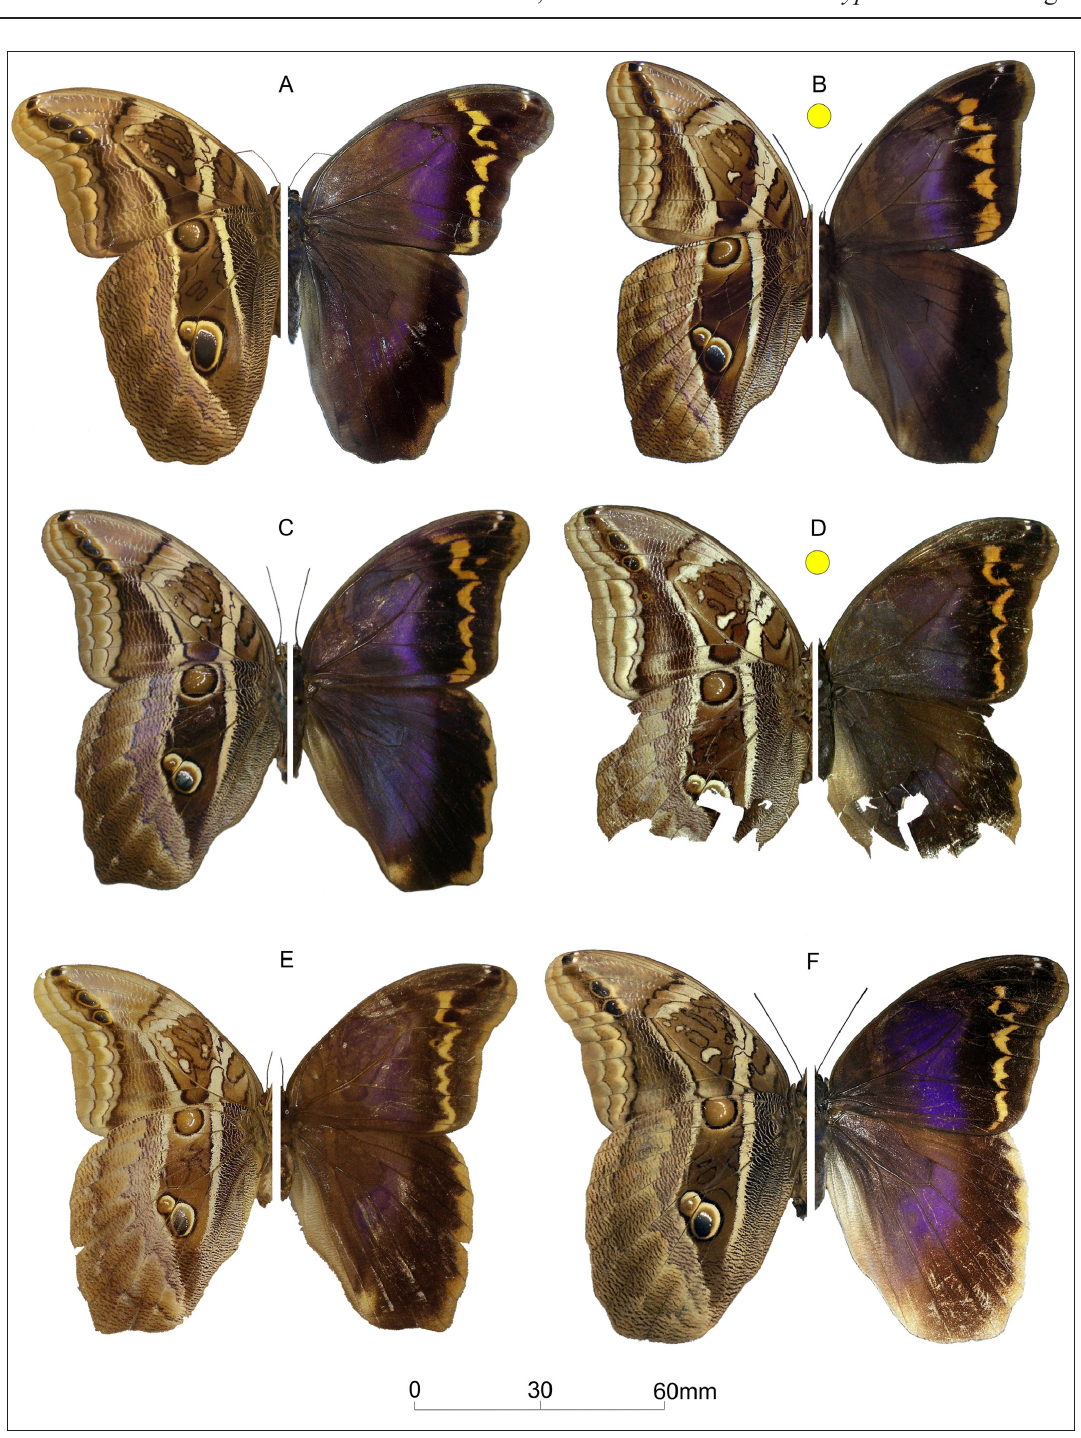
Fig. 7. Habitus of females. Yellow spot: paratype (PT). A . Eryphanis zolvizora zolvizora (Hewitson, 1877) (San Jacinto, Bolivia; BMNH). B . Eryphanis zolvizora chachapoya ssp. nov., PT (San José de Molinopampa, Amazonas, Peru; MNHN, PBGL 198). C . Eryphanis zolvizora greeneyi Penz & DeVries, 2008, stat. rev. (Ecuador; JFLC). D . Eryphanis zolvizora casagrande ssp. nov., PT (La Planada, Nariño, Colombia; IAvH). E . E. z. casagrande ssp. nov. (Huigra, Chimborazo, Ecuador; ANSP). F . Eryphanis zolvizora opimus (Staudinger, 1887) (Río Agua (presumably Río Aguacatal), Valle del Cauca, Colombia;